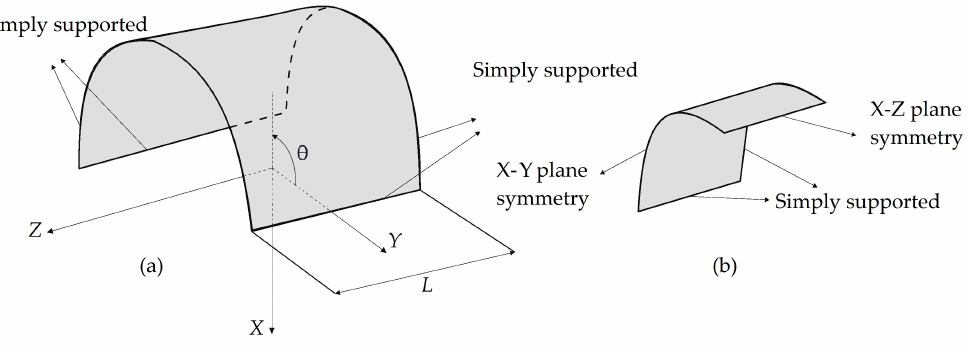
Figure6. ( a )Cylindricalshell; ( b )one-fourthoftheshell: Figure 6. ( a ) Cylindrical shell; ( b ) one-fourth of the shell: curved plate with symmetric boundary conditions.